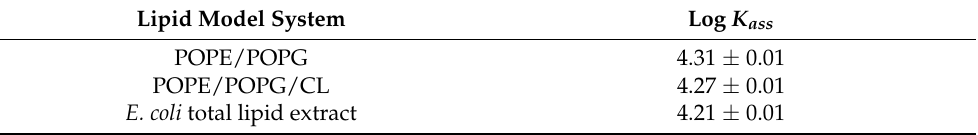
Table 1. Values of the association constants ( (cid:1837) (cid:3028)(cid:3046)(cid:3046) ) of cpx with OmpF proteoliposomes of POPE/POPG, POPE/POPG/CL and E. coli total lipid extract, obtained by steady-state fluorescence, using Equation (3). The presented values are the mean of, at least, three independent experiments (±SD).